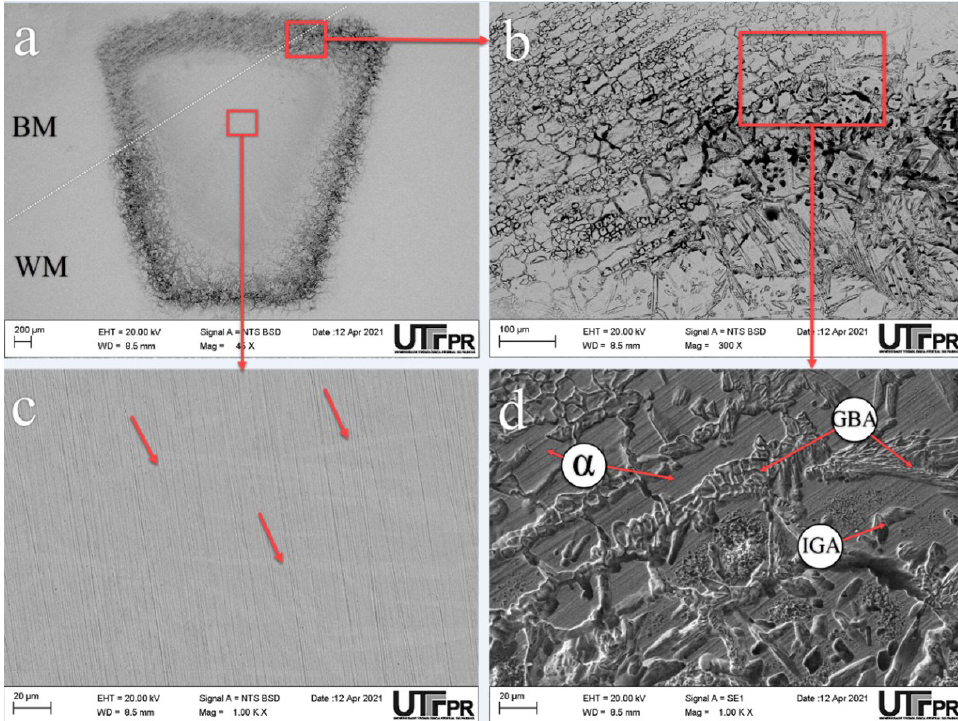
Figure 12. a. SEM micrograph (45X) of the crevice attacked site (** in Figure 10b) generated in a BM-WM sample in PD-PS-PD tests in NaCl 3.5% wt. solution, b-d.